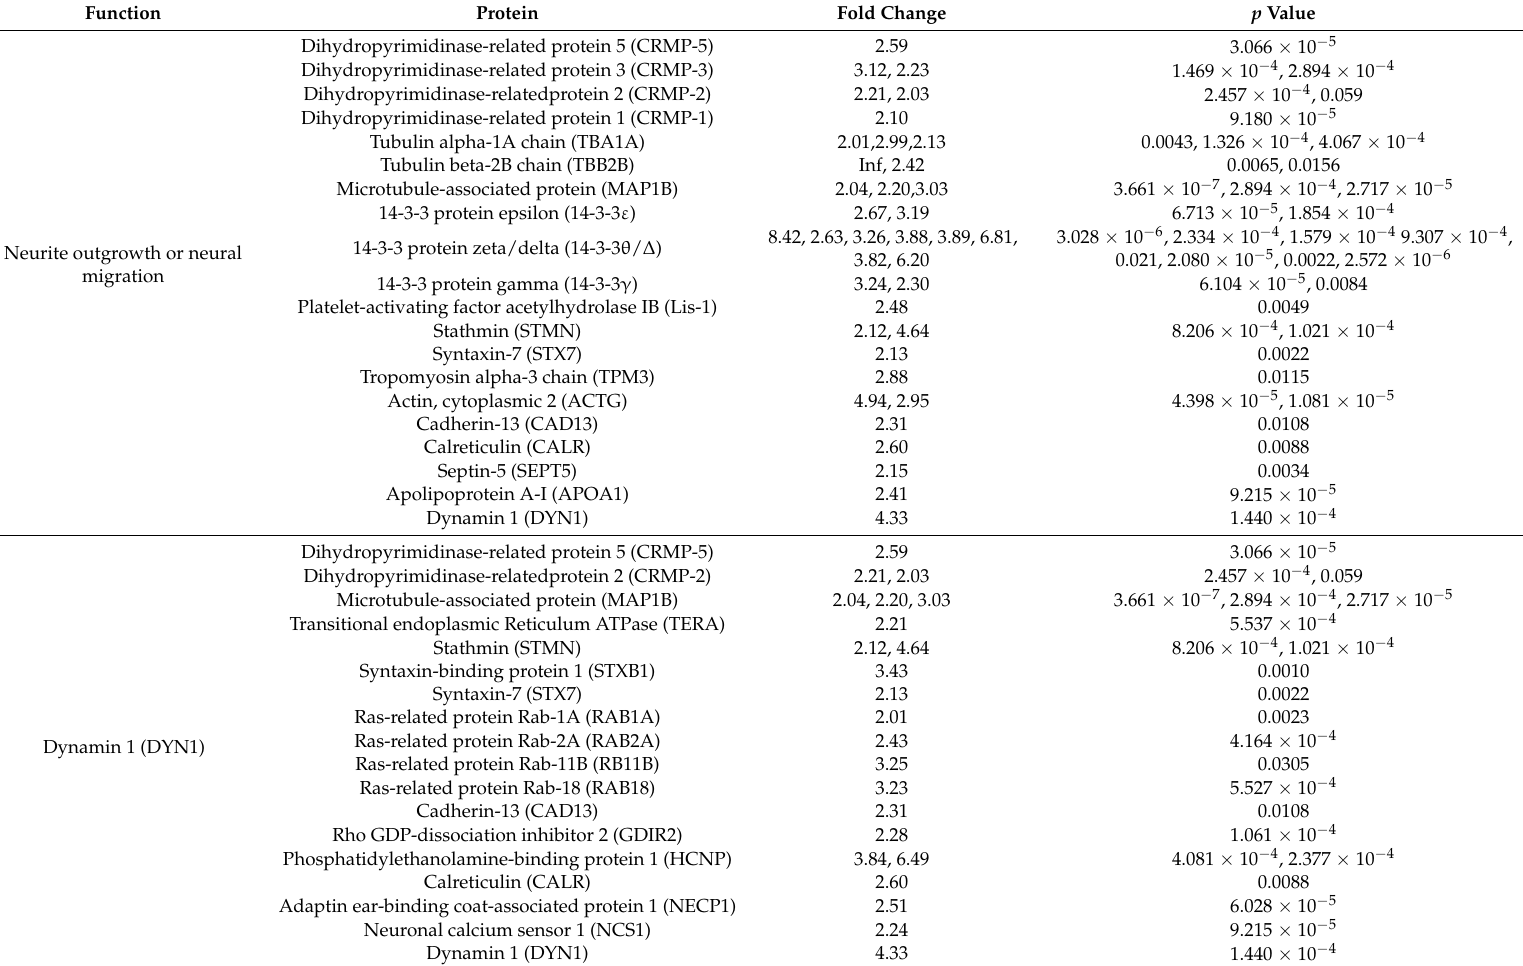
Table 1. Proteins involved in neurodevelopment or synaptic function identified through proteomic analysis of primary neurons 1 .